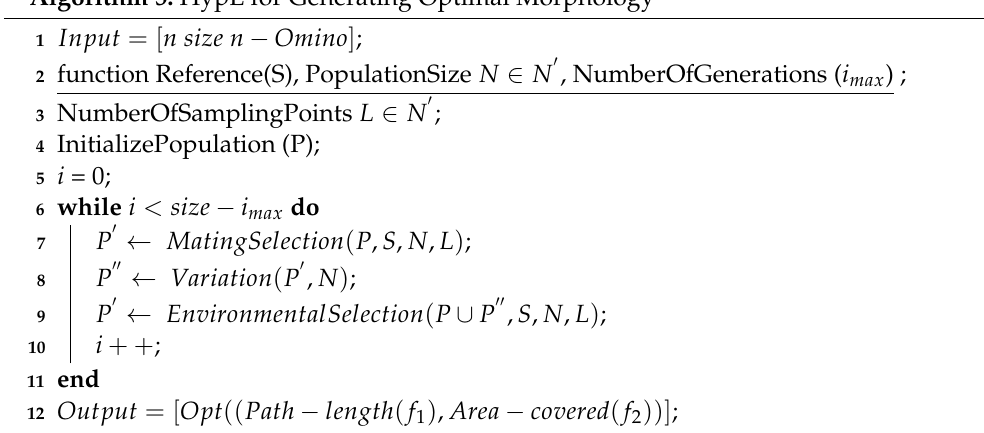
Algorithm 5: HypE for Generating Optimal